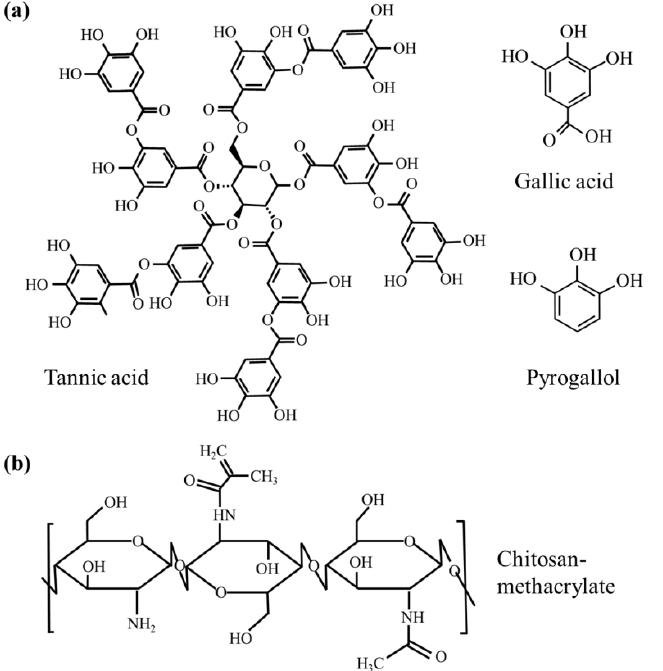
Figure 1. The chemical structure of ( a ) phenolic compounds (tannic acid, gallic acid and pyrogallol [30] and ( b ) CTSMA [31].